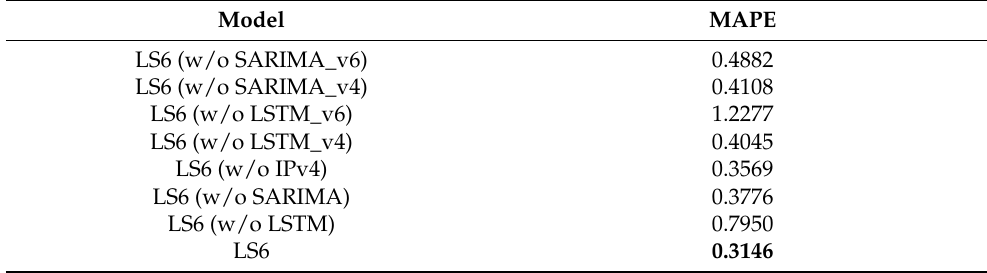
Table 4. Prediction performance of LS6 and variants (ECNU).